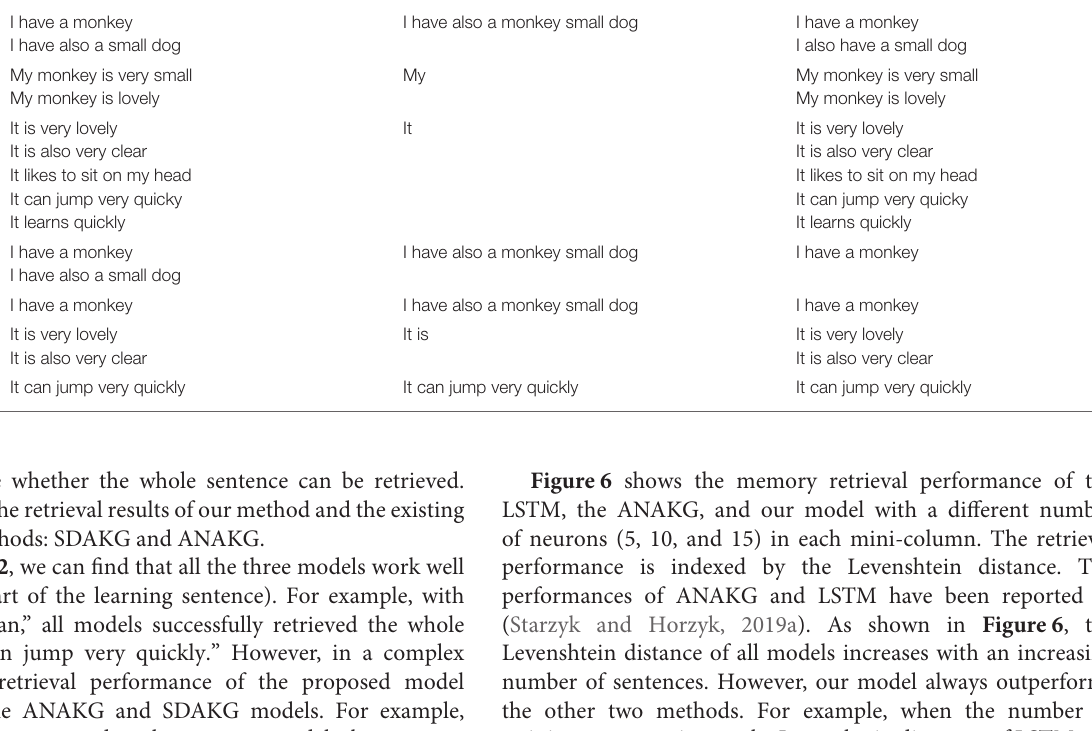
TABLE 2 | Memory retrieval performance of different models.